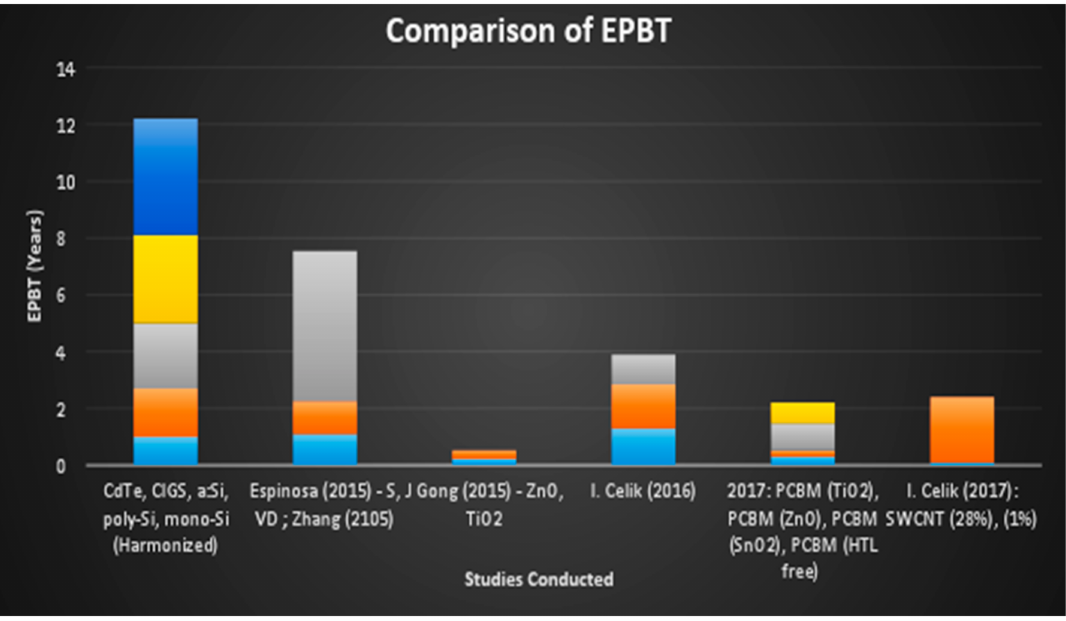
Figure 7. Comparison of the EPBT of different solar cells. Calculations have been done over time and the studies have been collected here. The figure shows the clear difference in EPBT based on materials used and calculation